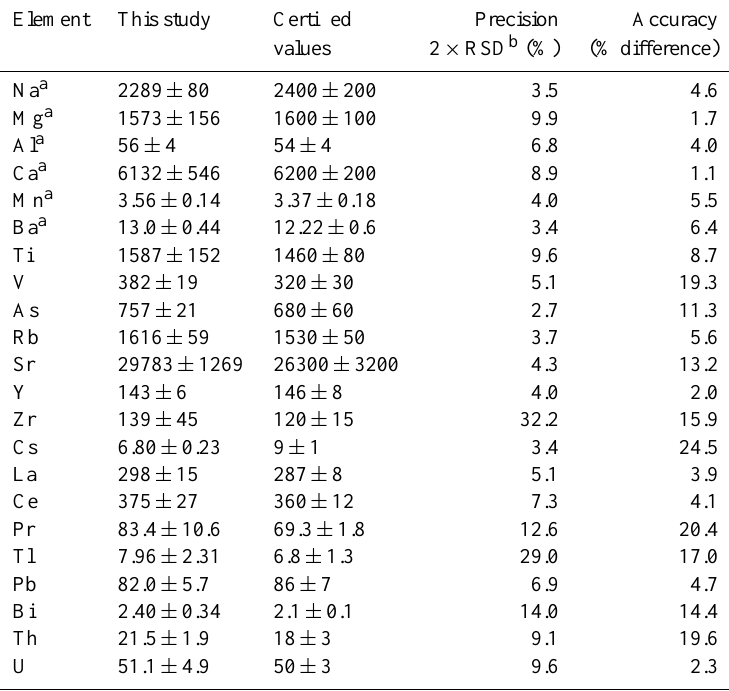
Table 1. Element concentrations (ppt, except where indicated) determined by repeated measurement of SLRS-4 riverine water standard ( n =82) with the precision and accuracy of measurements. Element This study Certified Precision Accuracy values 2 × RSD b (%) (% difference) Na a 2289 ± 80 2400 ±